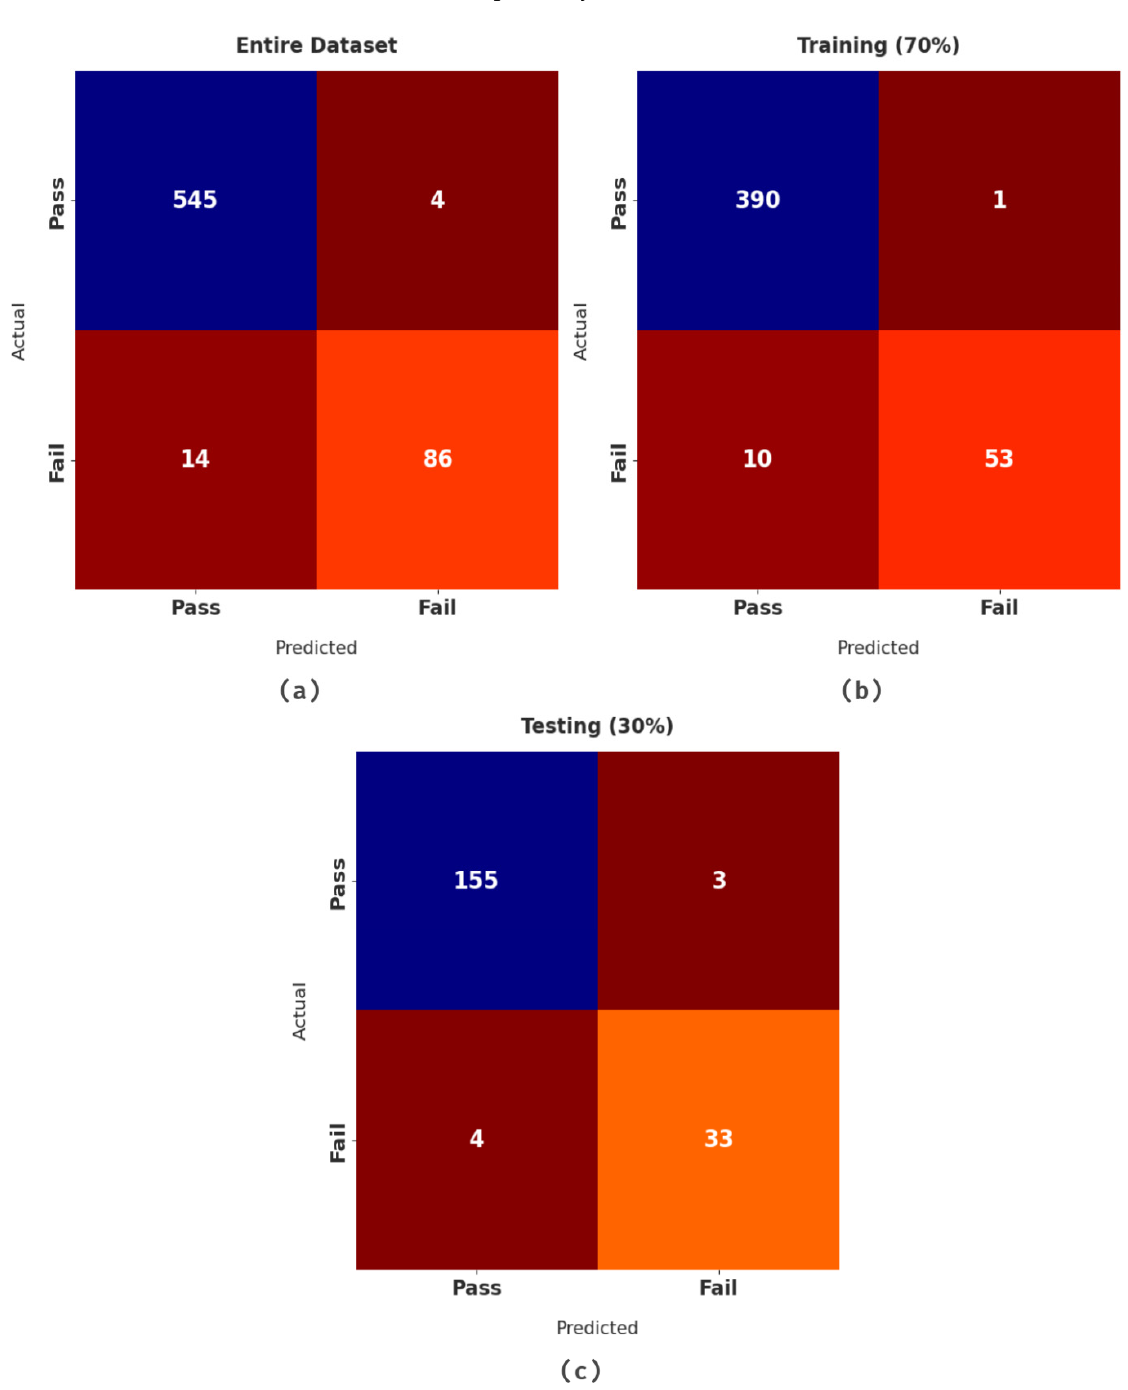
Figure 3. Confusion matrix of FSSML-EDM technique on test data. ( a ) Entire dataset, ( b ) 70% of training dataset, and ( c ) 30% of testing dataset